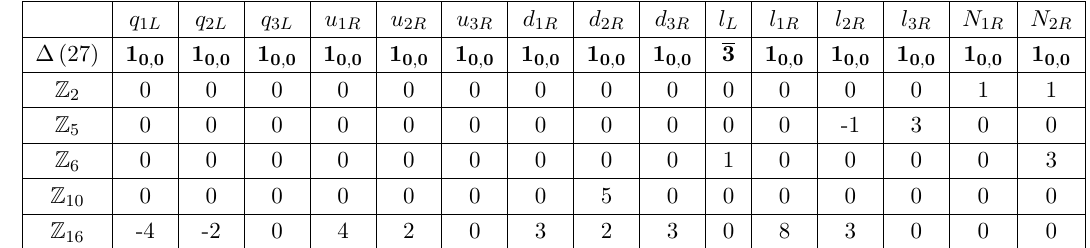
Table 2 . The same as in table 1 but for